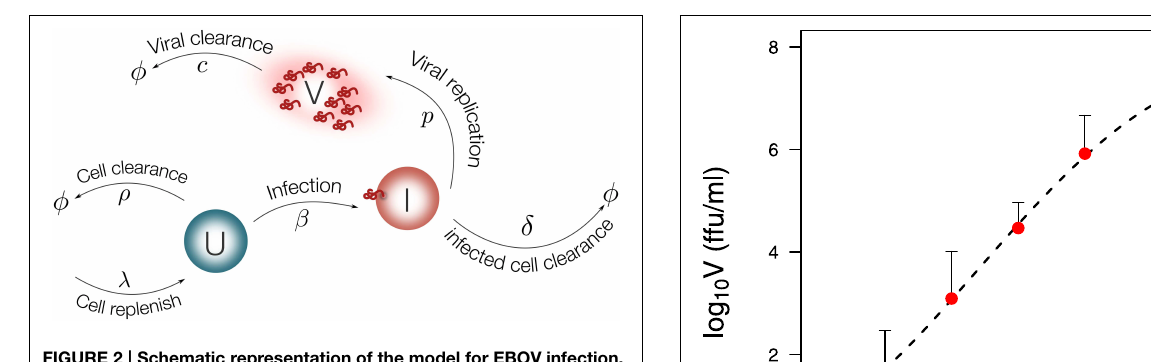
FIGURE 2 | Schematic representation of the model for EBOV infection. Target cells ( U ) are replenished with rate λ and die with rate ρ . Virus ( V ) infects target cells ( U ) with rate β . Infected cells are cleared with rate δ . Once cells are productively infected ( I ), they release virus at rate p and virus particles are cleared with rate c .